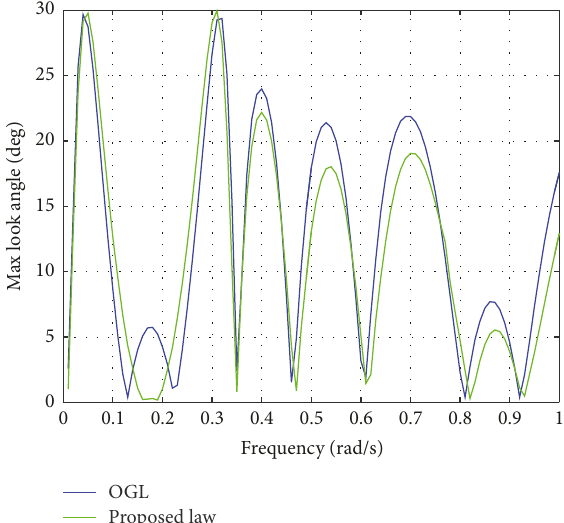
Figure 16: Max look angle of OGL and proposed law under different sinusoidal acceleration of target.